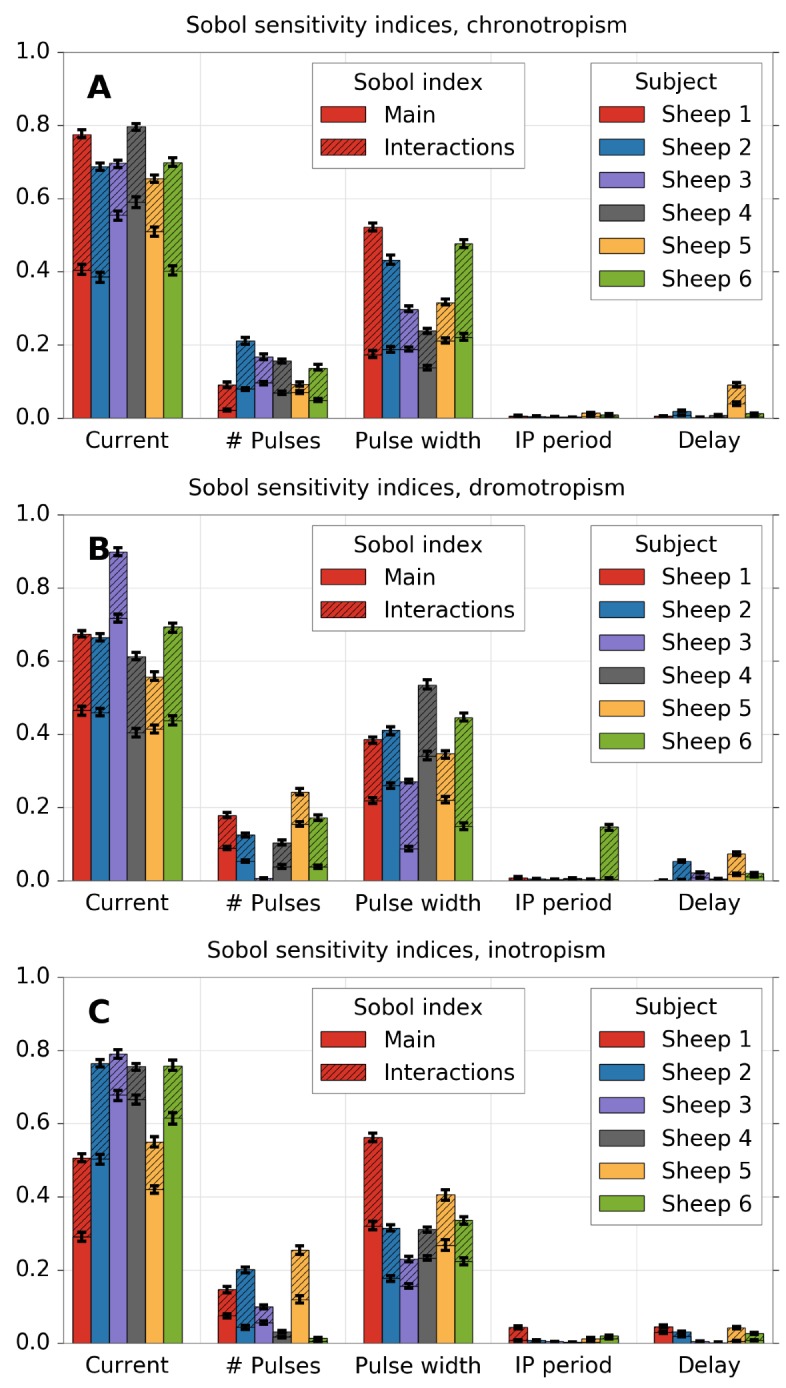
Estimation of Sobol’s main and interactions indices for each VNS parameter on each cardiac effect.A) chronotropic effect, B) dromotropic effect and C) inotropic effect. Total effects are equal to the sum of main and interactions effects (the whole color bar).